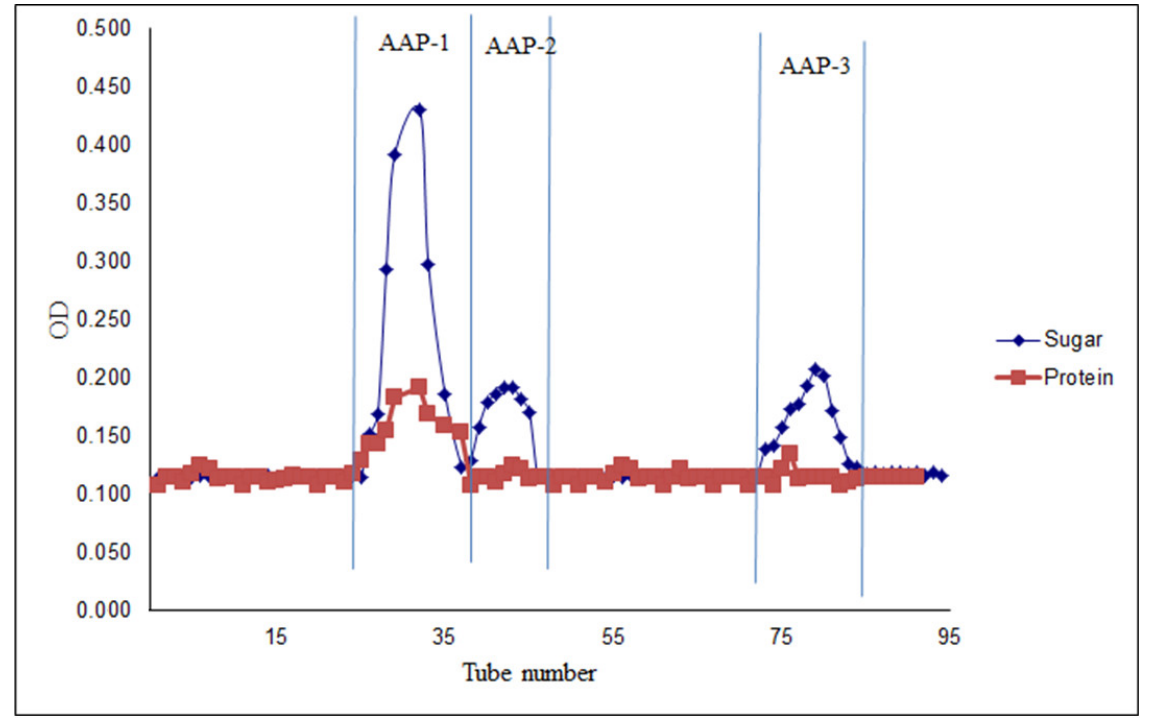
Figure 1. Flow chart for the extraction of polysaccharides from A . annua [21,32].